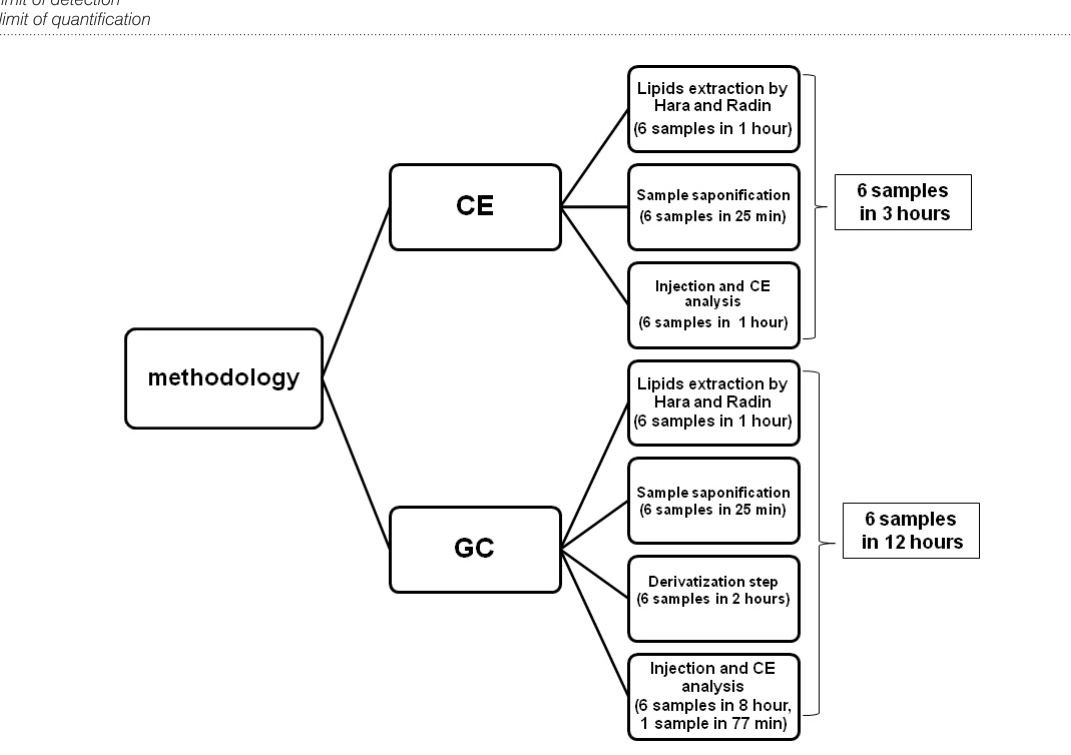
Figure 8. Analytical throughput comparative scheme between CE and GC